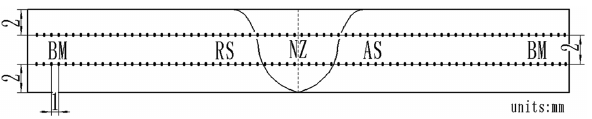
Figure 3: Schematic diagram of